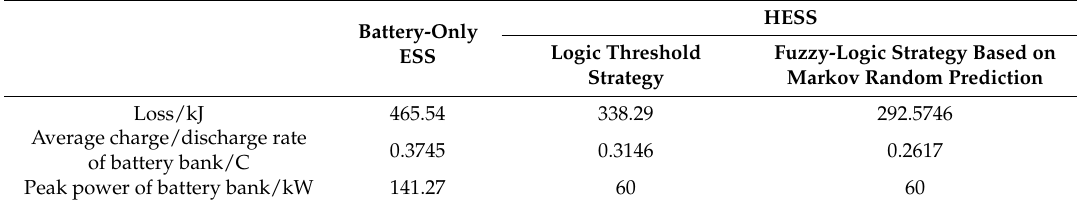
Table 5. Performance comparison of the battery-only ESS and HESS with different power management strategies.